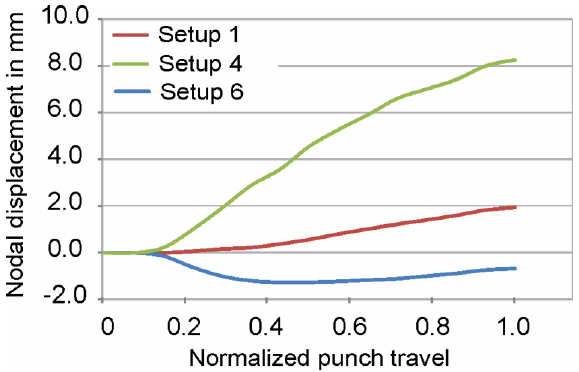
Figure 13. Weld ‐ line movement using nodal displacement for Setups 1 (steel/steel), 4 (steel/polymer K3), and 6 (steel/multi ‐ spring).